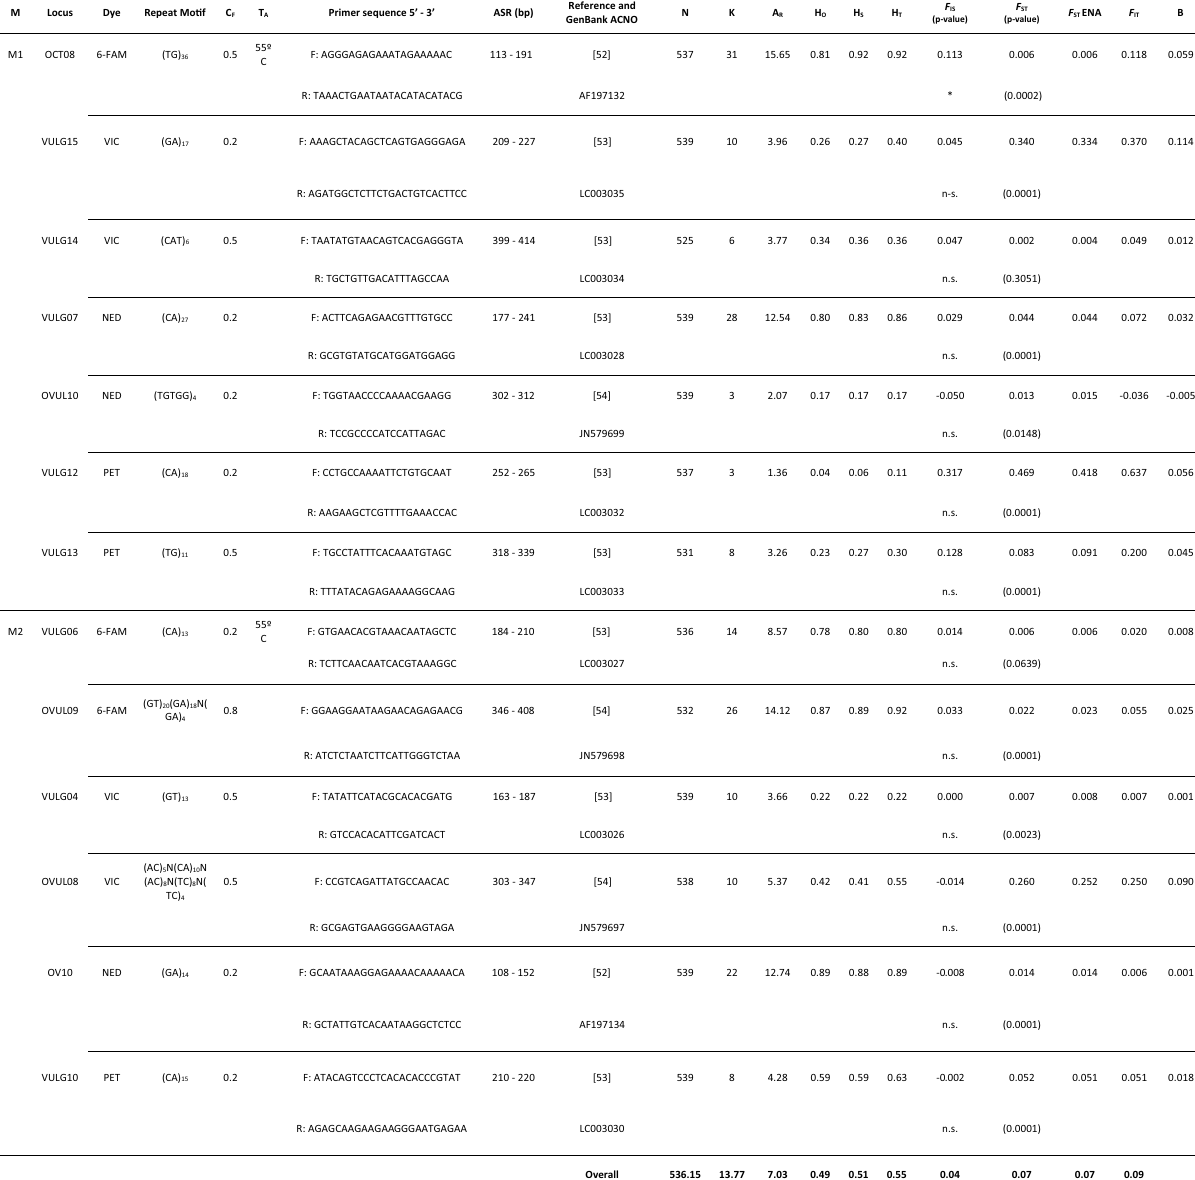
Table 1. Overall microsatellite information based on multiplex PCRs typifying O. vulgaris populations coming from 9 different localities of the Iberian Peninsula and the Canary Islands. M multiplex, C F PCR final concentration, T A : annealing temperature, ASR Allele size range in base pairs, REF reference where markers are reported, N sample size, k number of alleles per locus, A R allelic richness for the minor possible number of diploid individuals by sample (n = 23), H O observed heterozygosity, H S within population gene diversity, H T overall gene diversity. Weir and Cockerham 55 F statistics: F IS , F ST , F ST ENA (excluding null alleles following Chapuis and Estoup 56 ) and F IT . B: Brookfield 1 statistic for null allele’s